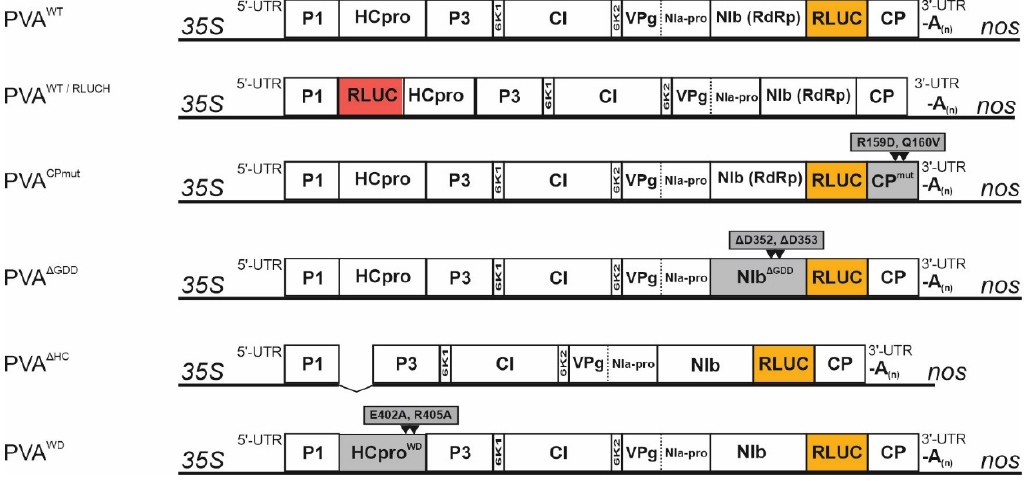
Figure 1. Schematic diagrams of viral constructs used in this study.